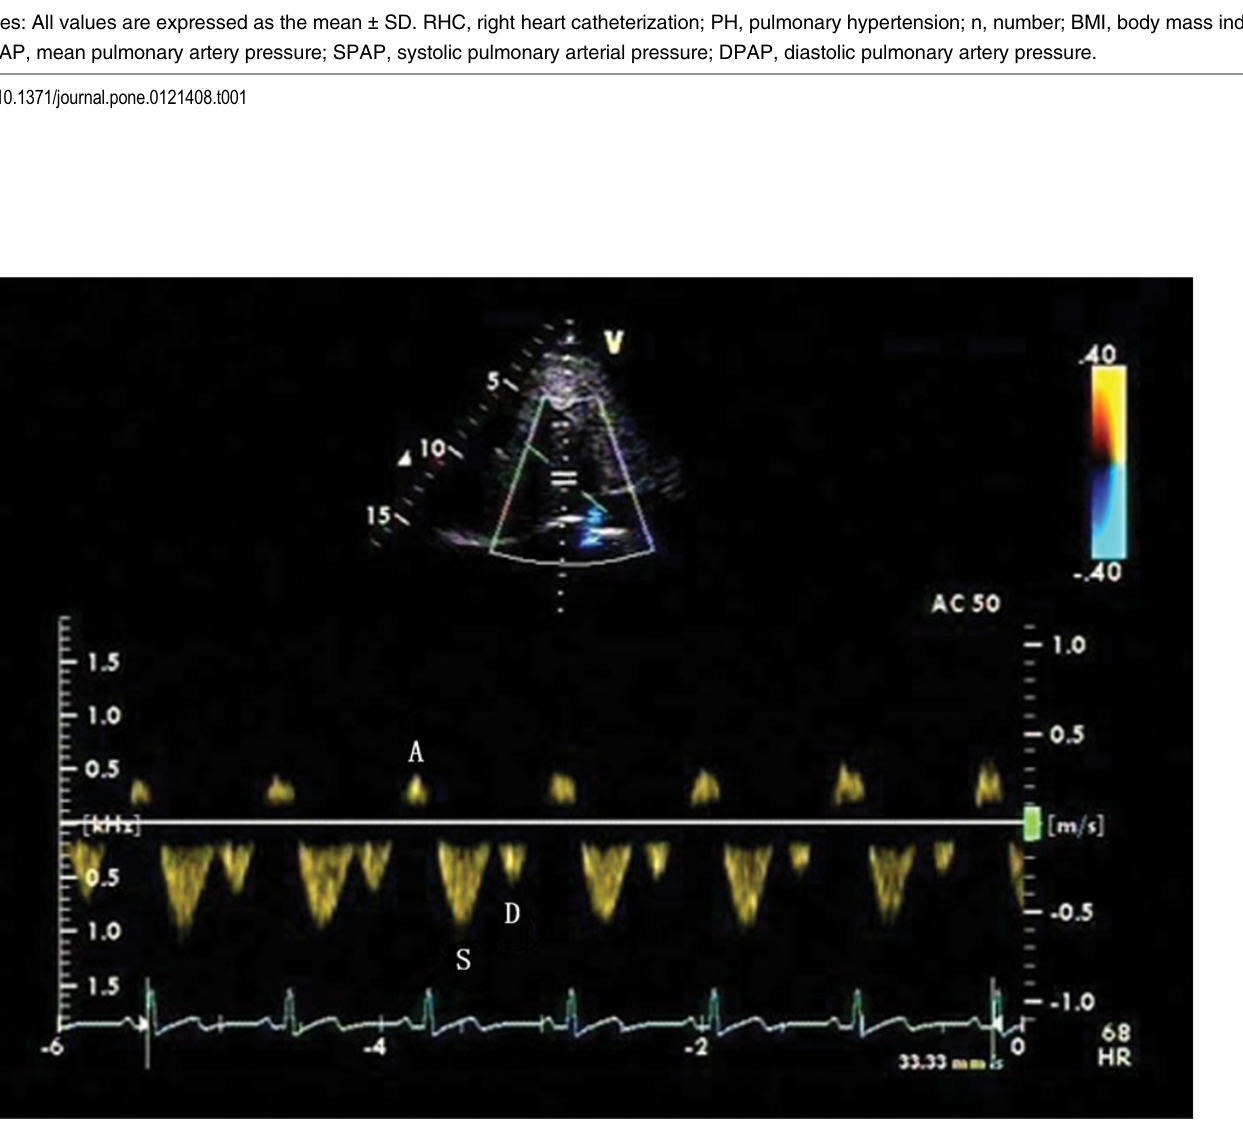
Fig 1. Tri-phasic Doppler flow spectra of the middle hepatic vein (MHV) in the control group. Doppler spectra of MHV obtained from a patient with atrial septal defect with the mean pulmonary artery pressure (MPAP) of 13 mmHg. The tri-phasic waveform includes ventricular systolic (S wave), ventricular diastolic (D wave) and atrial reversal (A wave)